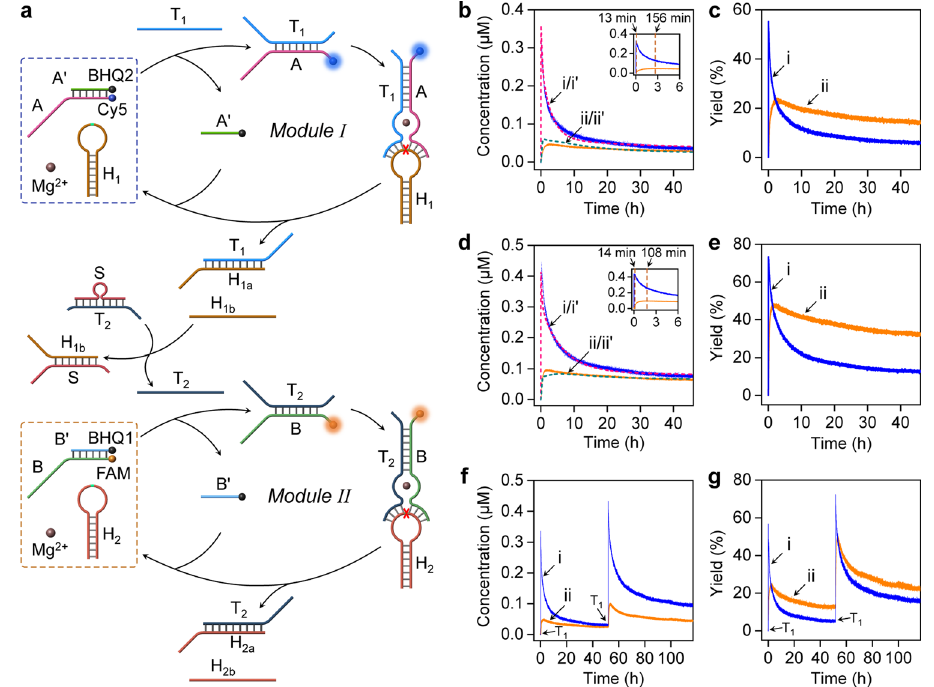
Fig. 2 | Triggered operation of a two-layer transient DNAzyme cascade. a Schematic T 1 -triggered operation of the cascaded module I and II using S/T 2 as coupler. The cascade involves the simultaneous operation of transient DNAzymes T 1 /AandT 2 /B. b Transientconcentrationchangesinthepresenceof T 1 =1.2 μ M(A/ A ’ 0.6 μ M, H 1 3 μ M, B/B ’ 0.2 μ M, H 2 1 μ M, S/T 2 1.2 μ M) corresponding to: DNAzyme T 1 /A - (i-solid line) experimental result; (i ’ -dashed line) computationally simulated result. DNAzyme T 2 /B - (ii-solid line) experimental result; (ii ’ -dashed line) compu- tationally simulated result. Inset: Transient curves at short time-intervals of the transientcurves. c Transientyieldsof:(i)DNAzymeT 1 /A;(ii)DNAzymeT 2 /B.Results were recorded inthe presenceof T 1 =1.2 μ M (A/A ’ 0.6 μ M,H 1 3 μ M,B/B ’ 0.2 μ M, H 2 1 μ M,S/T 2 1.2 μ M). d TransientconcentrationchangesofthecascadedDNAzymein